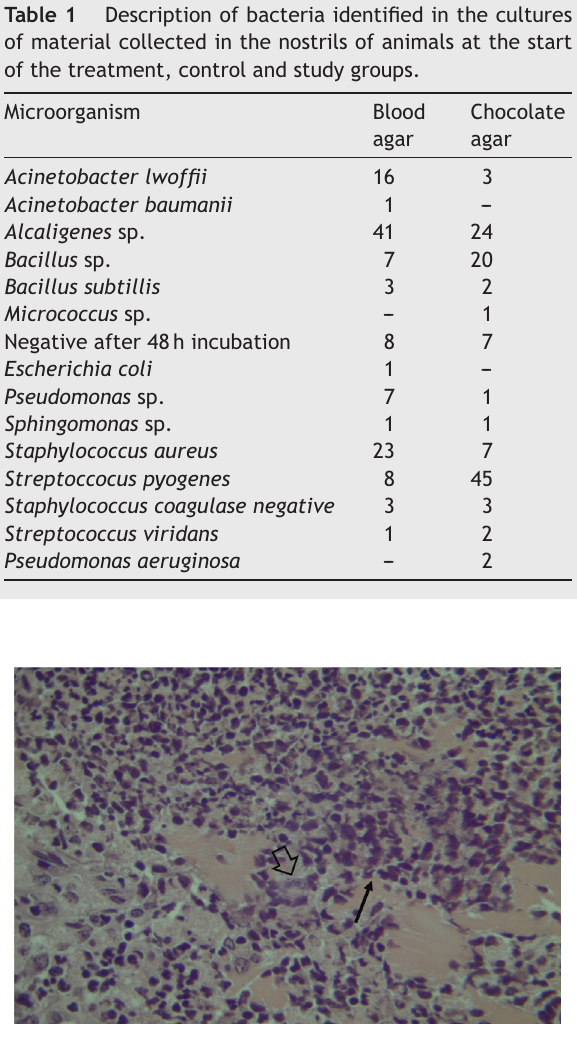
Mucosa of the maxillary sinus showing intense lym- phocytic infiltrate (narrow arrow) and glandular destruction (wide arrow) --- optical microscopy, HE staining, 200 × .